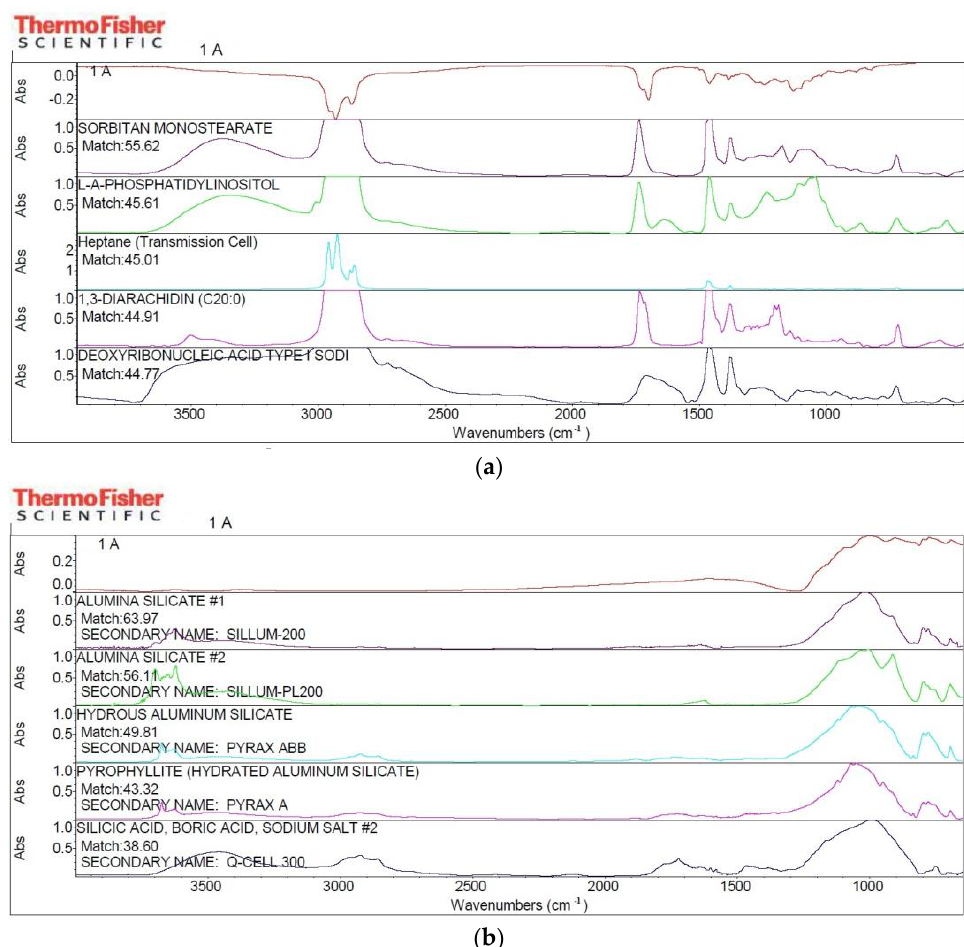
Figure 12. FT – IR analysis of sterile material sterile dumps of sample 1A: ( a ) Băiuț sterile dump; ( b ) Ilba sterile dump.